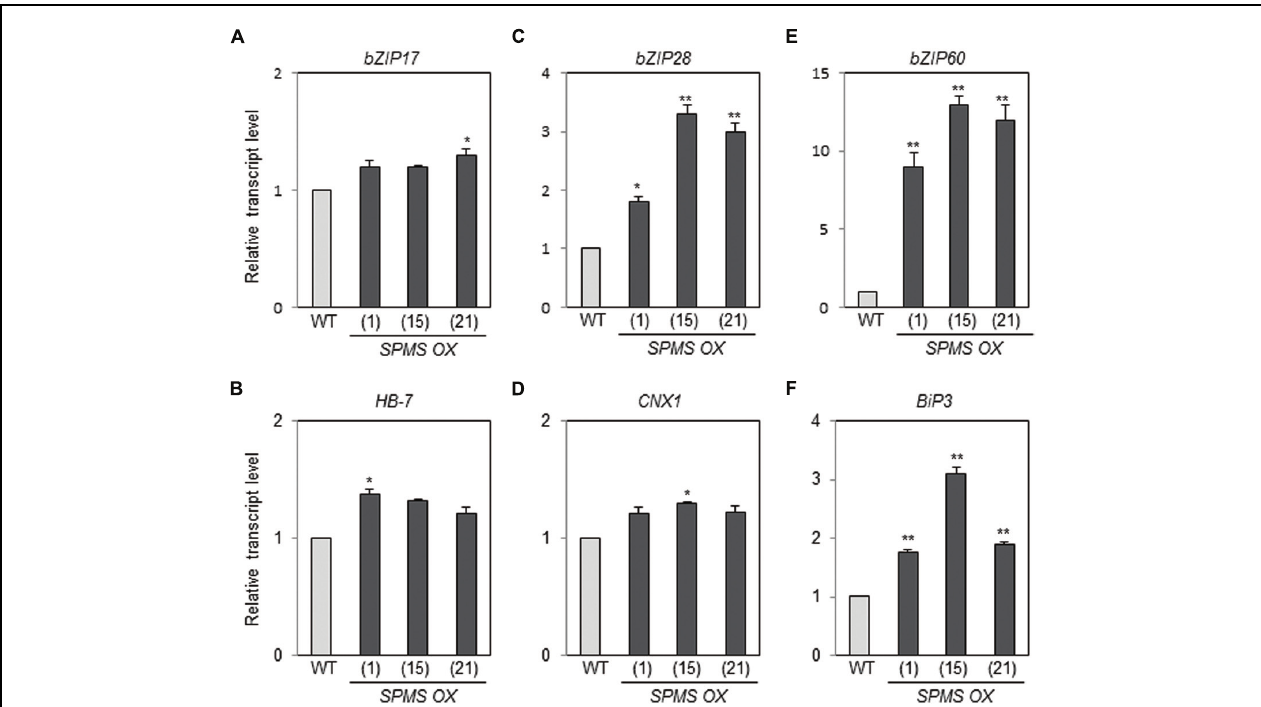
FIGURE 4 | Endogenous Spm induces the expression of bZIP17 , bZIP28, and bZIP60 and their target genes. The levels of bZIP17 (A) , bZIP28 (C) , and bZIP60 (E) transcripts, and their respective target gene transcripts [ HB-7 (B) , CNX1 (D) , and BiP3 (F) ] in the SPMS_OX transgenic lines were quantitatively determined by qRT-PCR analysis using the primer pairs listed in Supplementary Data Sheet S1. Values are mean ( ± SD) from three independent experiments. Asterisks indicate significant difference ( ∗ P < 0.05 and ∗∗ P <